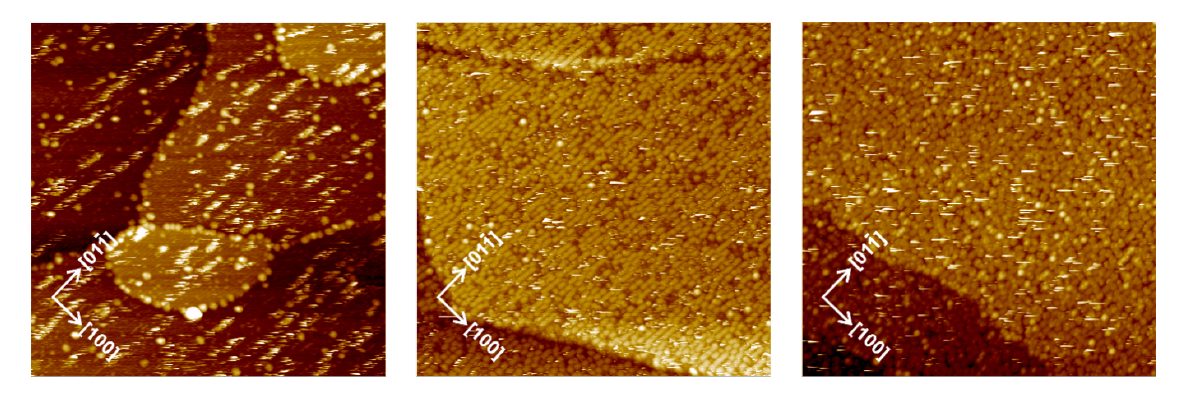
Figure 1: Adsorption of ZnPc molecules on the TiO 2 (011)-(2×1) surface. From left to right: empty state STM images of 0.1 ML, 0.9 ML, and 1.1 ML of ZnPc molecules respectively deposited on TiO 2 (011) surface at room temperature ( I = 3 pA, U = 2 V). Image size: 100 × 100 nm 2 .